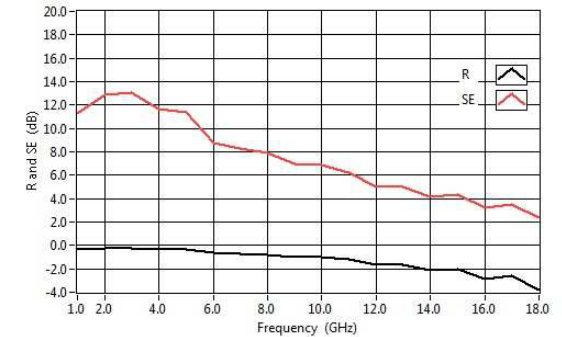
Figure 9: Reflectivity (black line) and SE (red line) vs. frequency of a 5 mm side dimension mesh grid.